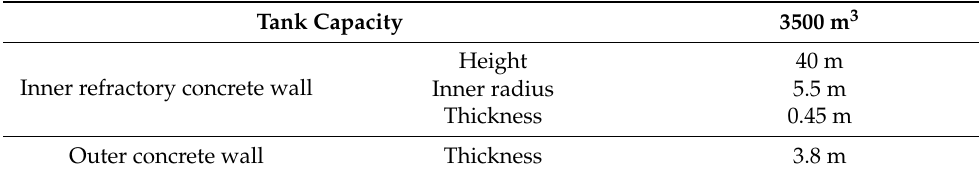
Table 3. Conceptual design